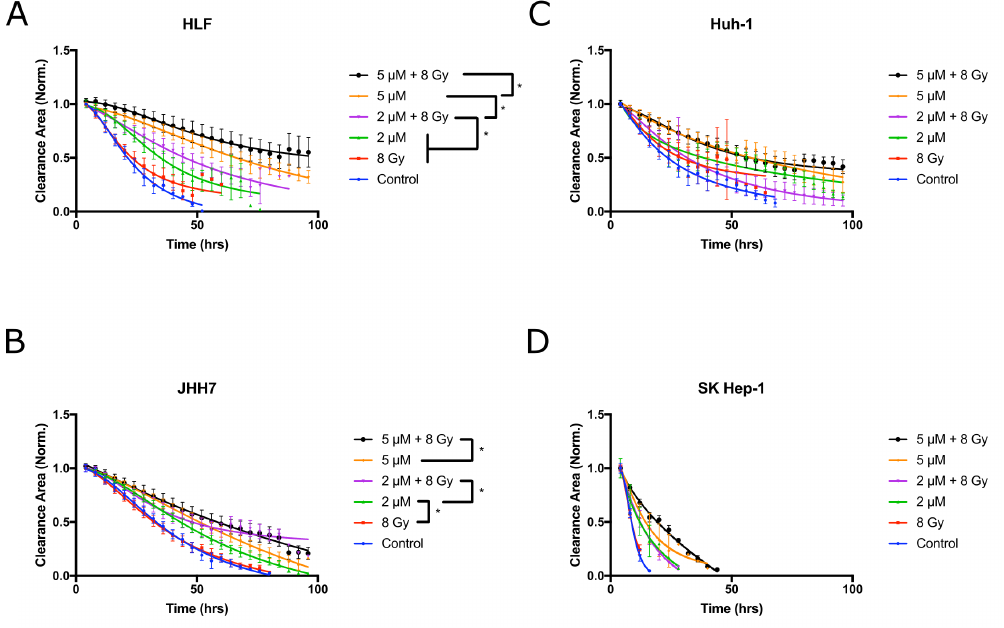
Figure 4. Treatment with vandetanib and radiation inhibits the migration of cells into a scratched area clearance. HCC cell lines ( A ) HLF, ( B ) JHH7, ( C ) HuH-1, and ( D ) SK-Hep-1 were plated to confluence onto 96 well plates, and a 2 mm section was cleared to generate a void. The wells were imaged every 4 h to monitor cell migration into the void. Lower values indicate faster migration and closure of the clearance. A significant, dose-dependent reduction in migration was demonstrated following vandetanib treatment (Multiple comparisons * p ≤ 0.05), an additive reduction in migration was observed in conjunction with radiation (non-parametric ANOVA p ≤ 0.05 for HLF and